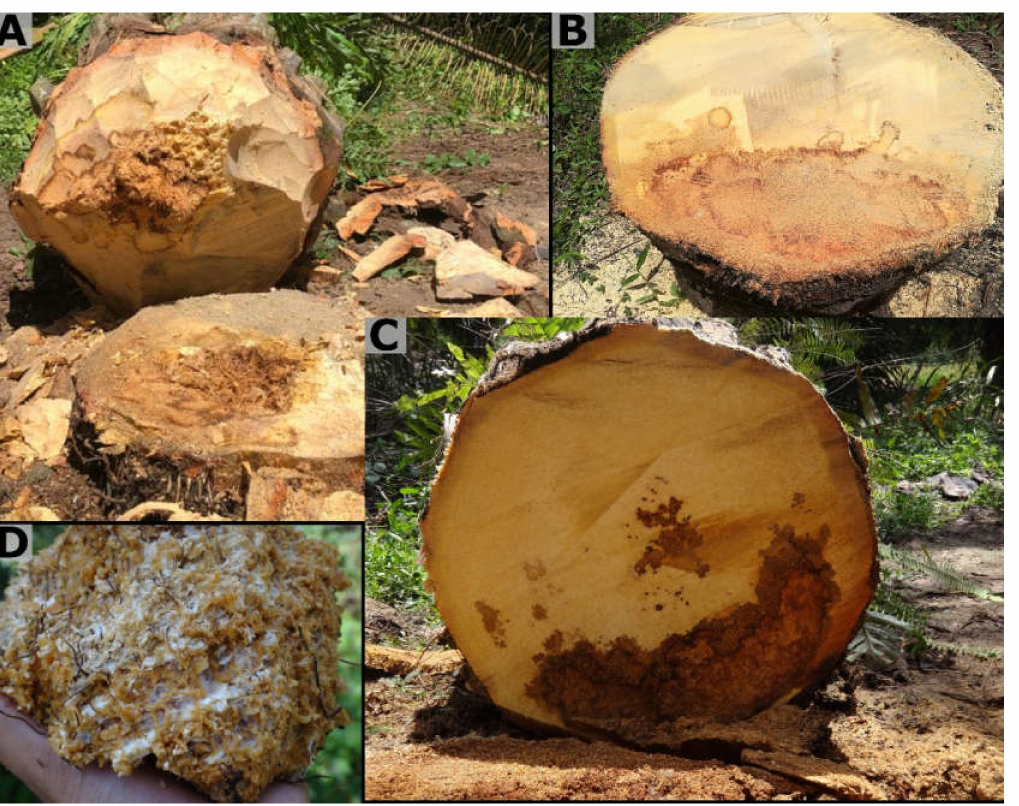
Figure 2. Internal development of lesions of Ganoderma in oil palms in Colombia. ( A , B ) Presence of lesions with irregular border ( C ) Delimitation of light and dark areas. ( D ) Presence of mycelium in debris